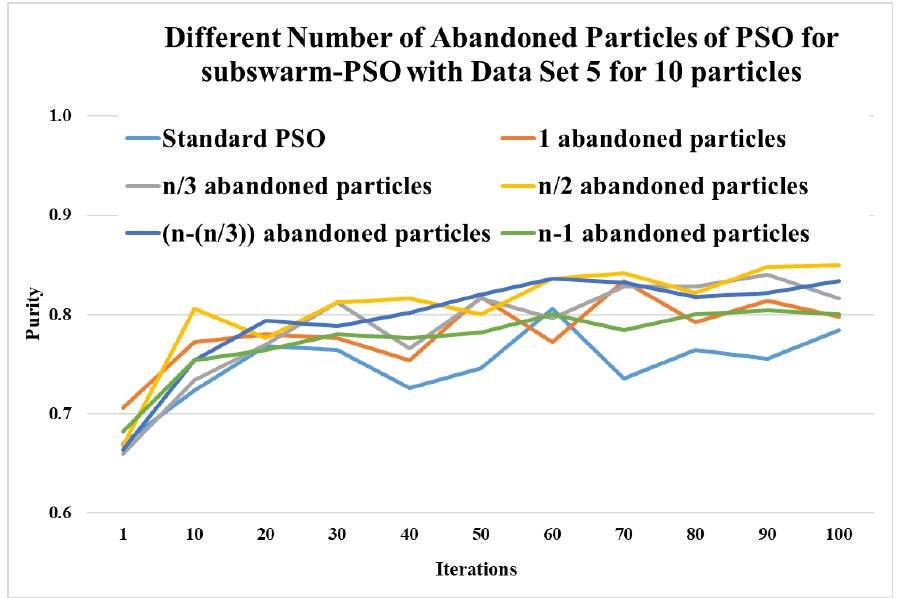
Figure 3. Comparison of different numbers of abandoned particles of subswarm-PSO for data set 5 with 10 particles.